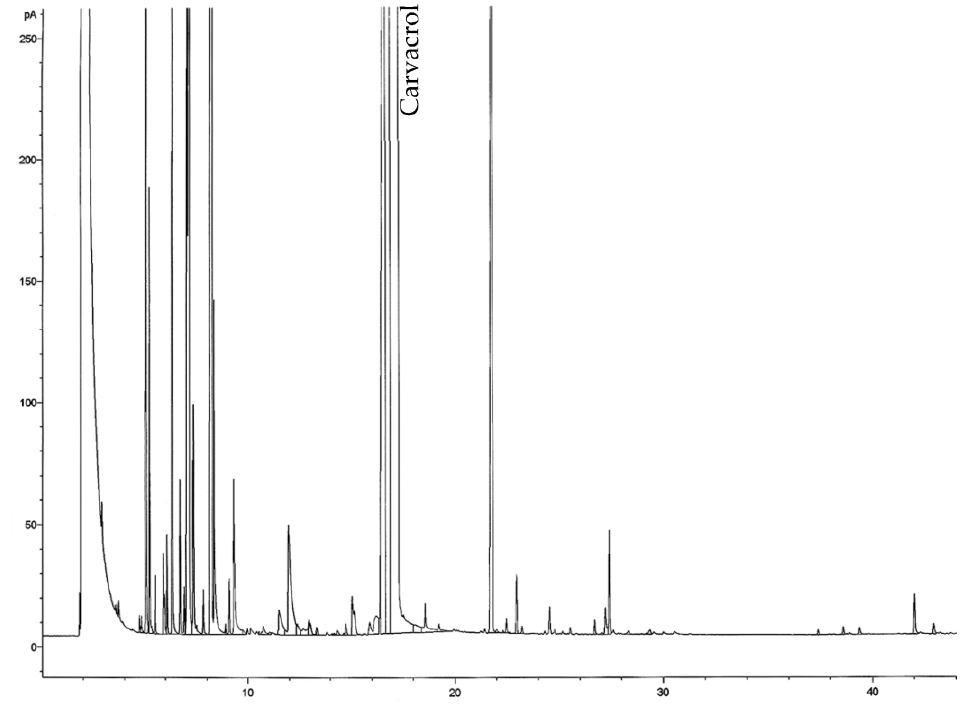
Figure 1. GC - FID chromatogram of EO of Thymbra capitata on the SPB - 1 column. Figure 1. GC-FID chromatogram of EO of Thymbra capitata on the SPB-1 3.2. Phytochemical Characterization of HRW by HPLC - PDA - ESI - MSn T. capitata hydrodistillation residual water (HRW) was characterized relative to its phytochemical composition by HPLC - PDA - ESI - MSn (Figure 2 and Table 2). Figure 2. HPLC - PDA - ESI - MSn chromatogram of hydrodistillation residual water from T. capitata , recorded at 320 nm. 0